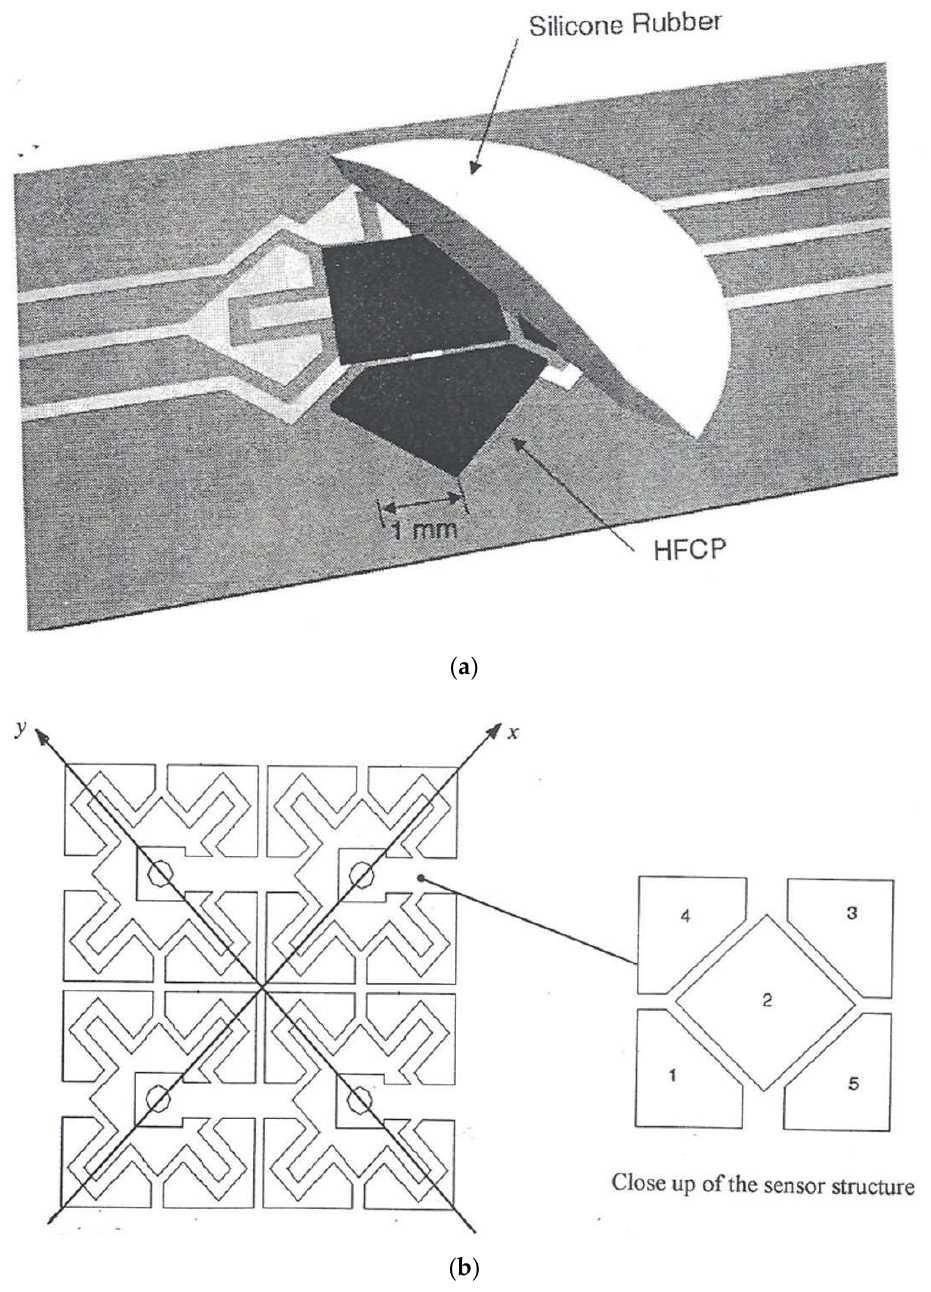
Figure 1. ( a ) The structure of the artificial skin sensor; ( b ) the compound sensor used in the indentation